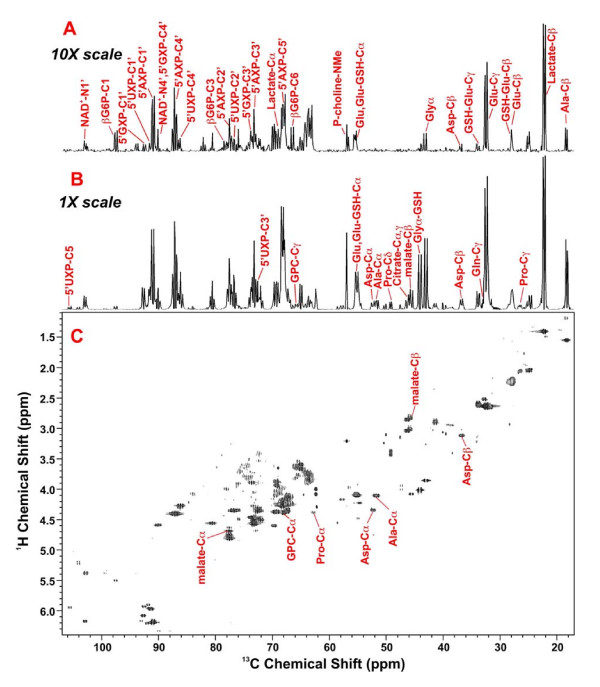
2-D 1H-13C HSQC analysis of Rh30 cells and myocytes. Both cells were cultured in [U-13C]-glucose for 24 hr before trichloroacetic acid extraction and HSQC measurement at 14.4 T. The spectra were recorded with 0.14 s acquisition in t2 and 34 ms in t1. The data table in t1 was linear predicted to 1024 complex points and zero filled to 2048, so that 13C-13C couplings (35–45 Hz) were resolved. Panel C displays the 2-D contour map of the Rh30 cell extract while panels B and A are respectively the 1-D 13C projection spectra of the 2-D contour maps for Rh30 and myocytes. Both A and B were normalized to cell dry weight but A was plotted at 10× scale relative to B.